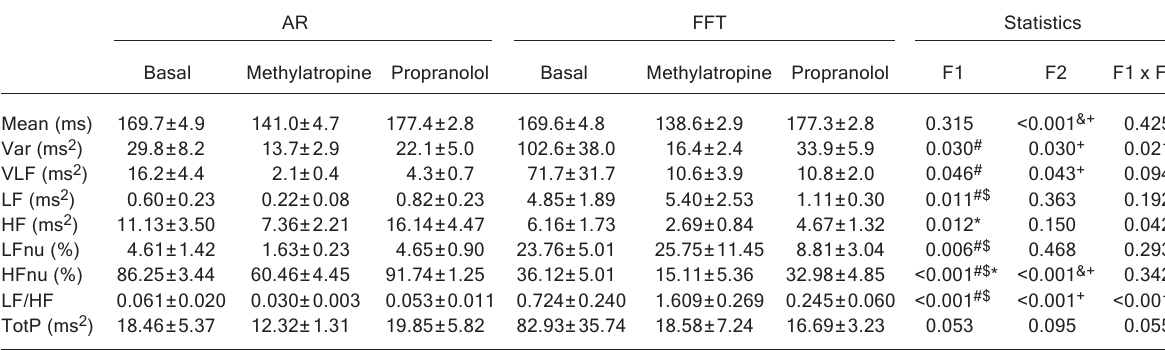
Table 3. Time- and frequency-domain analysis of pulse interval of normotensive rats (Wistar, N = 8) submitted to pharmacological blockade.